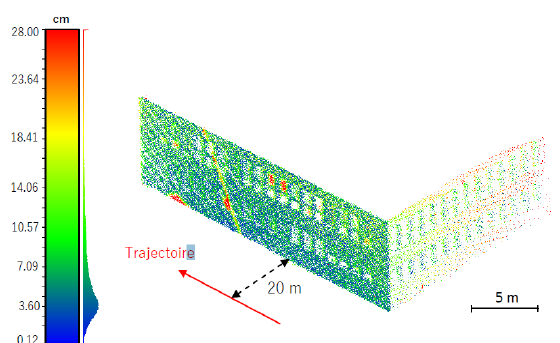
Figure 18: Difference VUX1-PUCK on a building. Rising of range increases the difference.